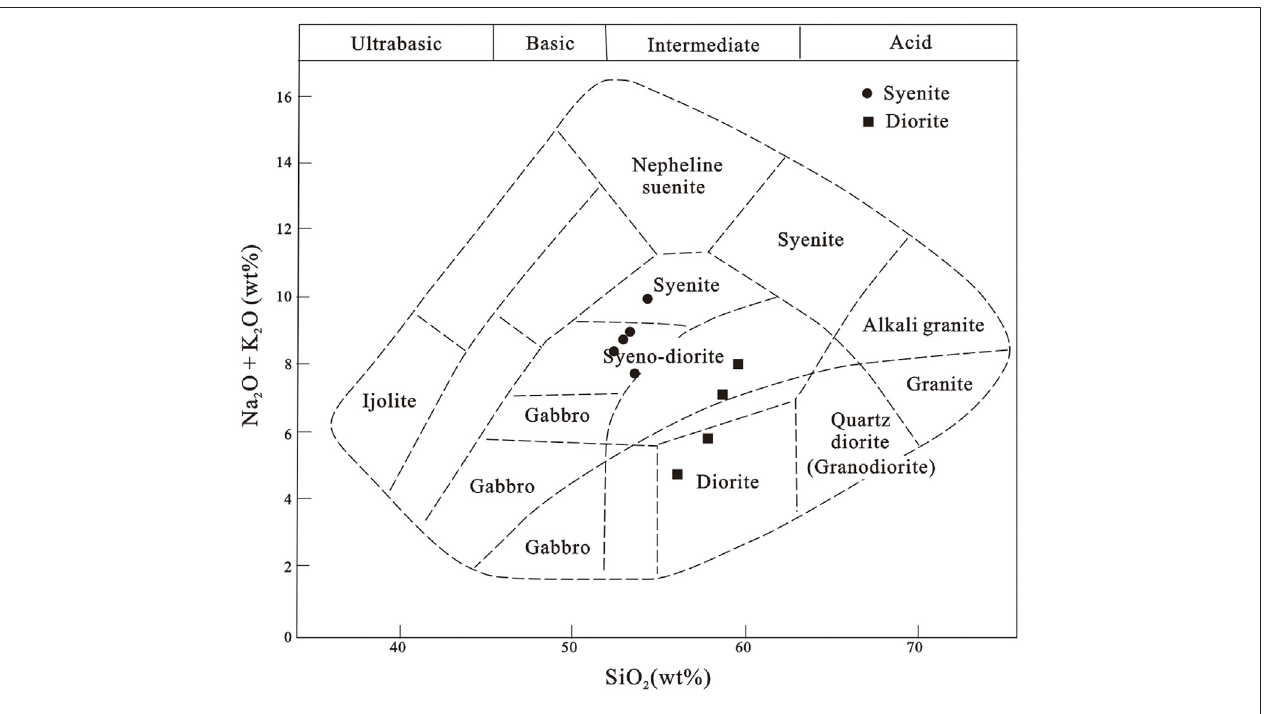
FIGURE 6 | TAS diagram of syenite and diorite, data from Wang and Zhu (2010).